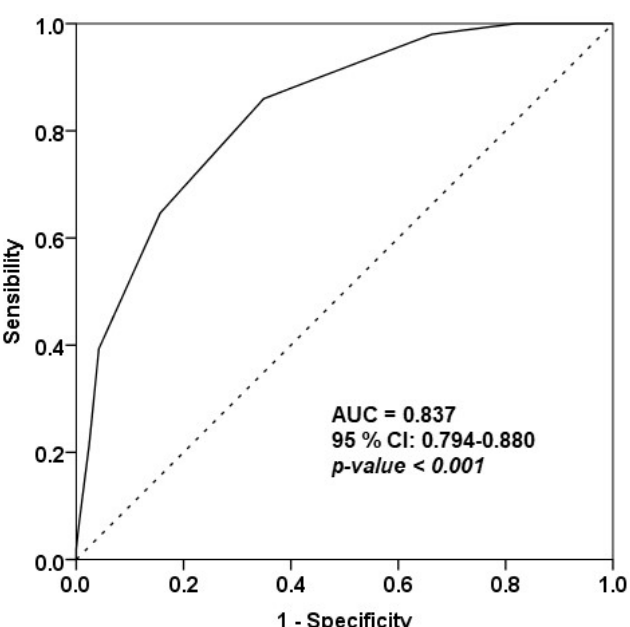
Figure 2. The Receiving Operating Characteristic (ROC) curve for MedQ-Sus questionnaire (AUC = area under the curve, 95 % CI = 95 % confidence interval).